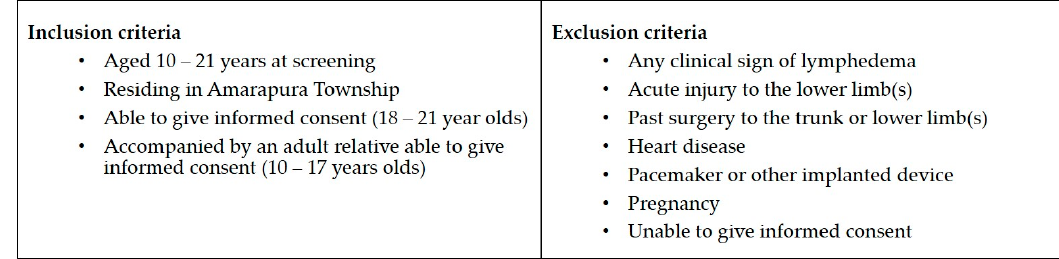
Figure 1. Participant inclusion and exclusion criteria.